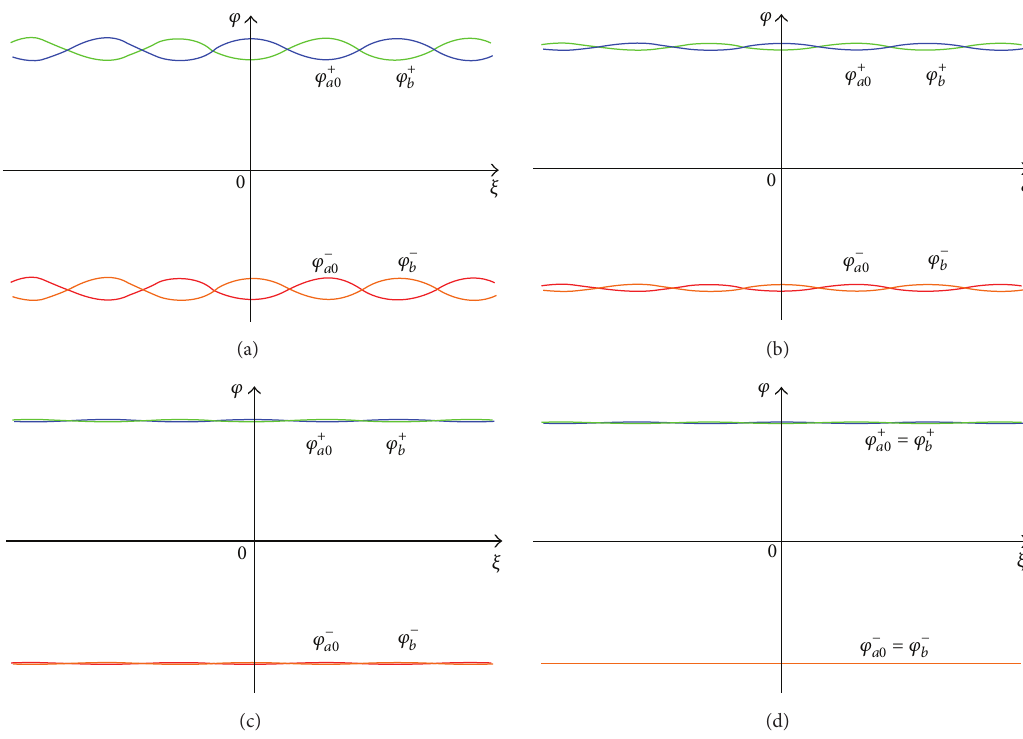
Figure 5: (The symmetric periodic waves become two trivial waves.) The varying process for the figures of 𝜑 ± 𝑎0 and 𝜑 ± 𝑏 when (𝑞,𝑝) ∈ 𝐴 12 and : 𝑝 = 3𝑞 2 /16𝑟 = −3 and (a) 𝑝 = −3 + 10 −1 , (b) 𝑝 = −3 + 10 −2 , (c) 𝑝 = −3 + 10 −3 , and (d) 𝑝 → 3𝑞 2 /16𝑟 + 0 , where 𝑟 = −1 , 𝑞 = 4, and 𝑙 6 𝑝 = −3 + 10 −6